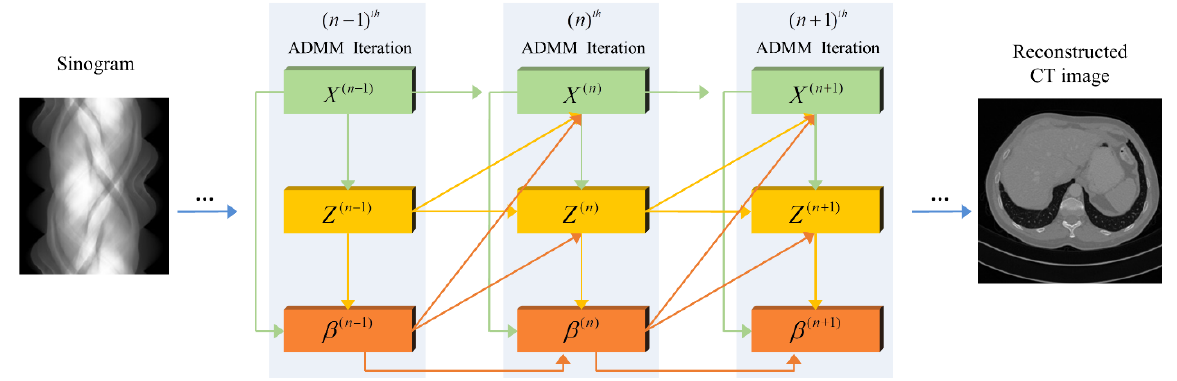
Figure 1. The overall structure of our proposed network. The modules with the three different colors correspond to layer( X ( n ) ), layer( Z ( n ) ), and layer( β ( n ) ). Each ADMM iteration of the network consists of these three types of layers.